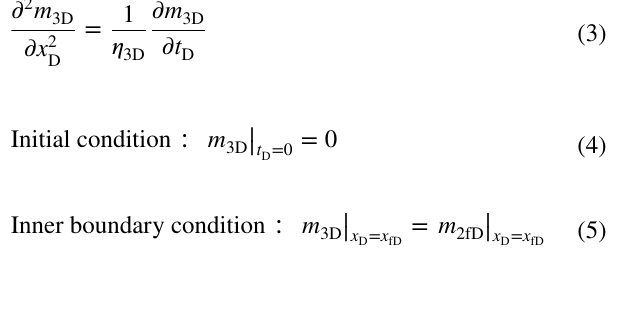
Fig. 1 Schematic of the trilinear flow model for MFHW in tight gas